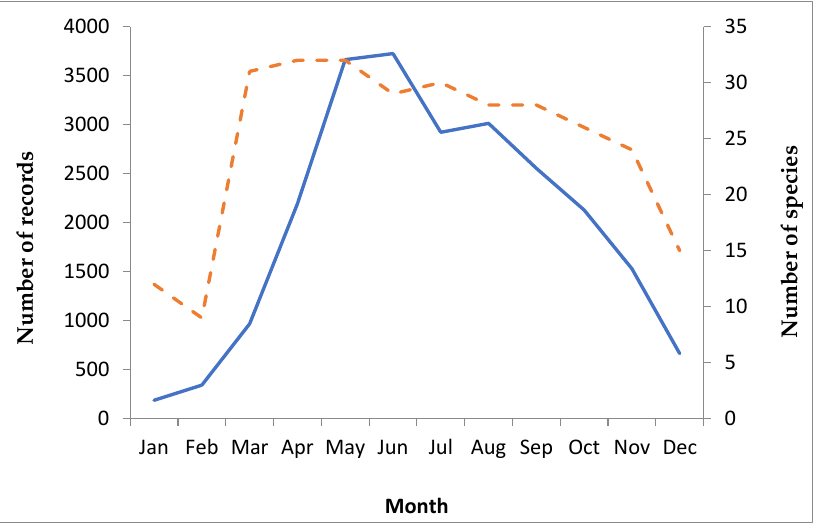
Figure 2. The total number of records (continuous blue line) and number of species recorded (dotted red line) for each month for the dragonflies and damselflies of Cyprus for the period 2013 – 2019.